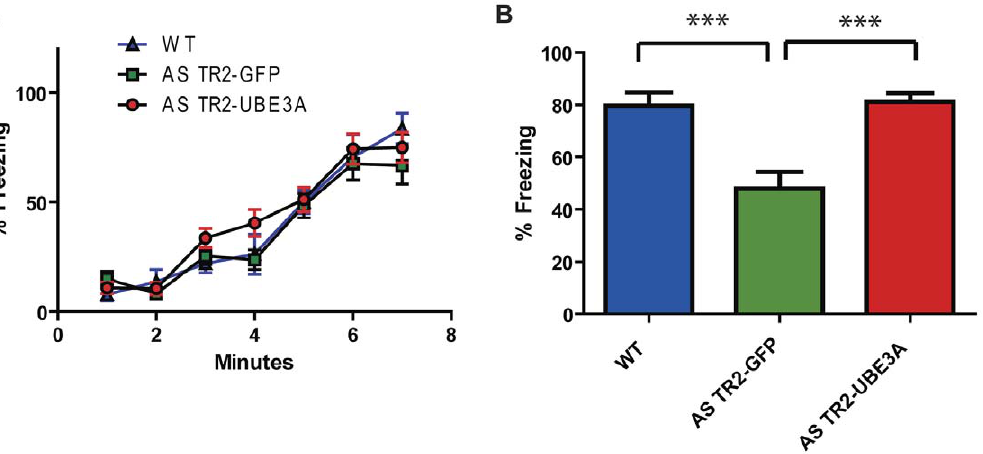
Figure 4. AS mice receiving TR2-UBE3A had significant improvements in associative learning. (A) There were no differences during the training phase of fear conditioning, indicating that all groups of mice were capable of freezing to the same extent. (B) AS TR2-GFP mice show significant deficits in contextual fear conditioning when assessed 24 h after training. AS TR2-UBE3A mice, however, froze at the same rate as the wildtype mice. Results shown represent the mean with standard error.